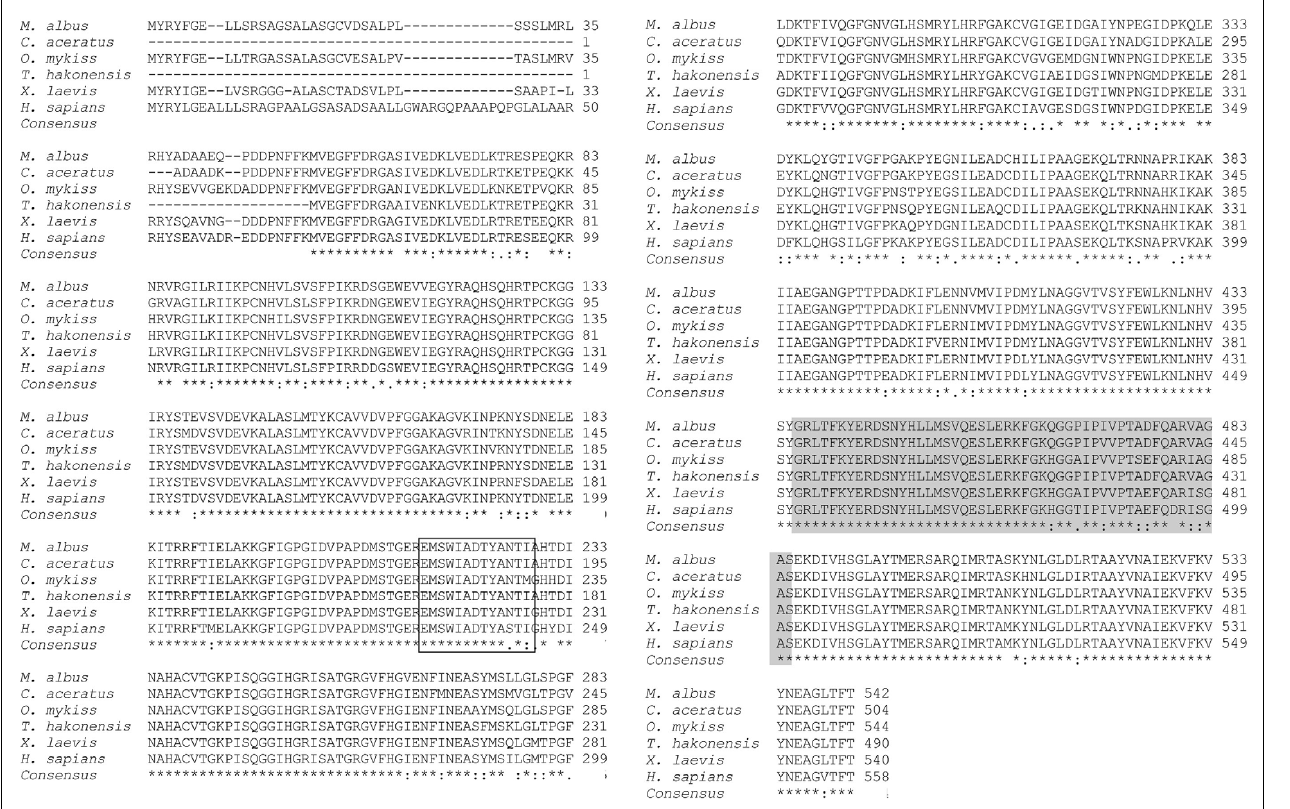
sapiens (NP_005262.1). Identical residues in the alignment are indicated by “ ∗ ”; similar amino acids in the alignment are indicated by “:”; dissimilar amino acids in the alignment are indicated by “.”. Residues involved in adenine binding domain are boxed; residues contributing to the antenna domain are shaded